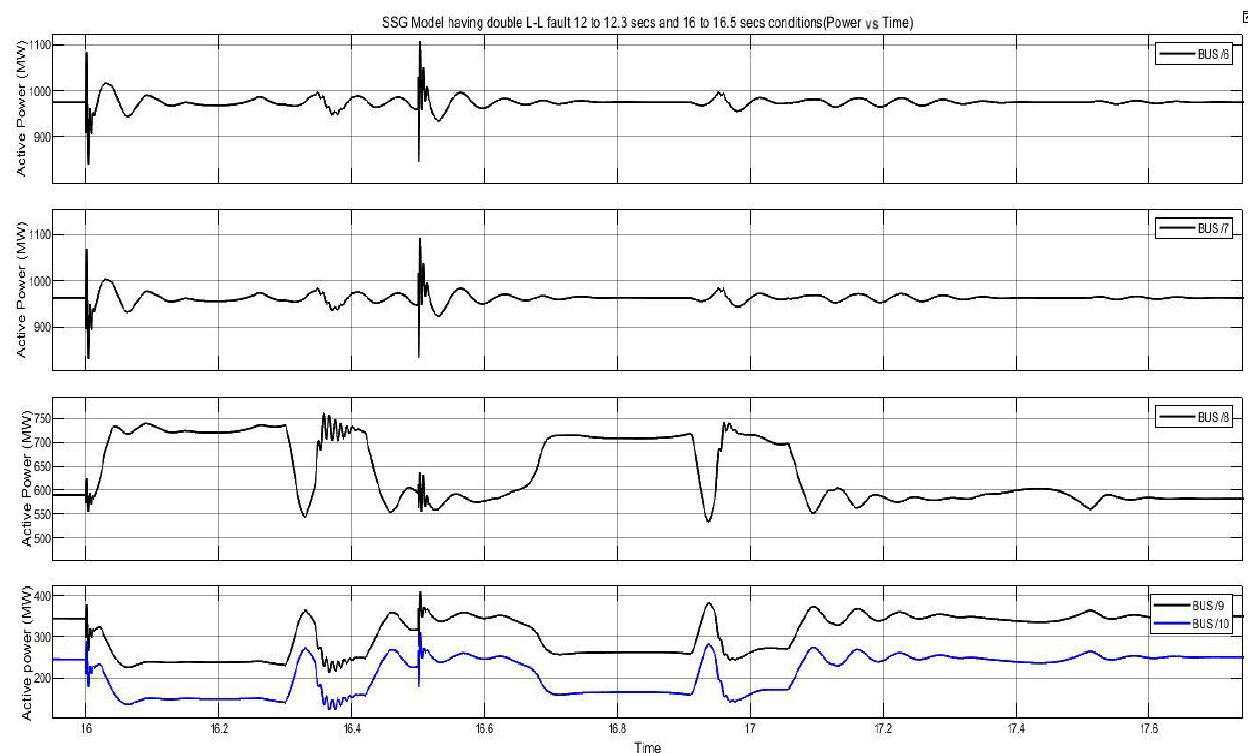
Figure 29. Transient stability being provided by UPFC after multiple double faults L-L introduced 12 to 12.3 s (Bus 6 to Bus 10).